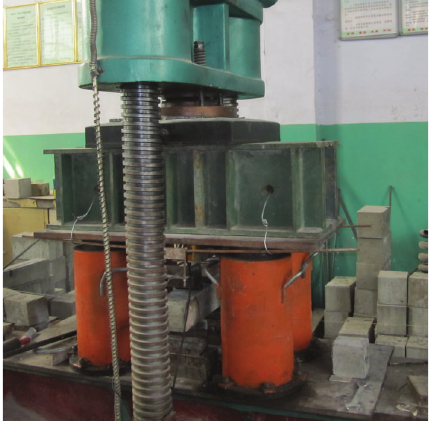
Figure 2: Testing apparatus of flexural